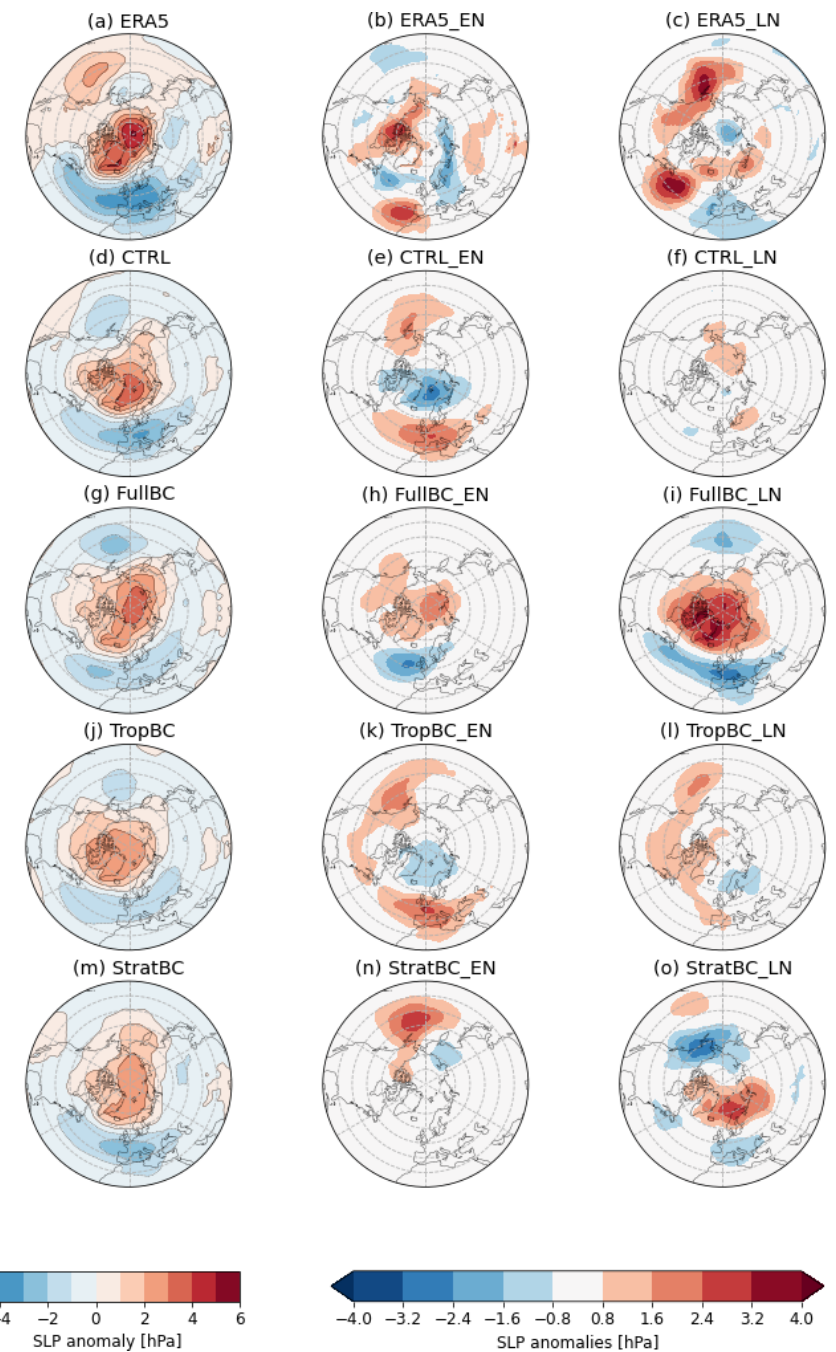
Figure 8. The left column shows composites of absolute SLP anomalies averaged over 30d after the central dates of SSWs for neutral ENSO conditions for the models and all years for ERA5. The middle and right column show the difference between SLP anomalies during El Niño (middle) and La Niña (right) minus neutral condition anomalies. ERA5 data from 1979–2019, 100 years for each model run (neutral, El Niño, and La